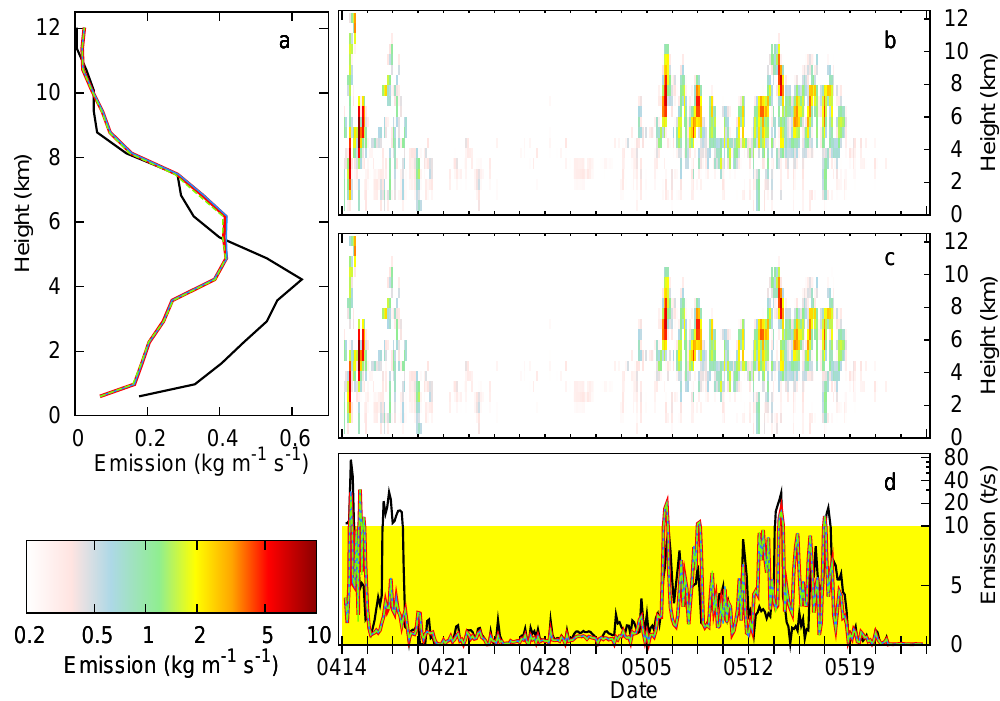
Fig. 4. Sensitivity to size distribution. (a) Comparison of temporally-averaged vertical profiles of ash emissions used a priori (black line) and obtained a posteriori by the ECMWF-based inversion when using our reference size distribution (red line), when using the size distribution shifted to a larger mode (blue line) and a smaller mode (dashed green line), as shown in Fig. 1. (b) A posteriori emissions as a function of altitude and time for the size distribution shifted to larger particle sizes. (c) A posteriori emissions as a function of altitude and time for the size distribution shifted to smaller particle sizes. (d) Vertically integrated a priori (black line) and a posteriori emissions (red, blue and green lines) as a function of time, for the different size distributions. Notice that in (a) and (d) , the red, blue and green lines nearly fall on top of each